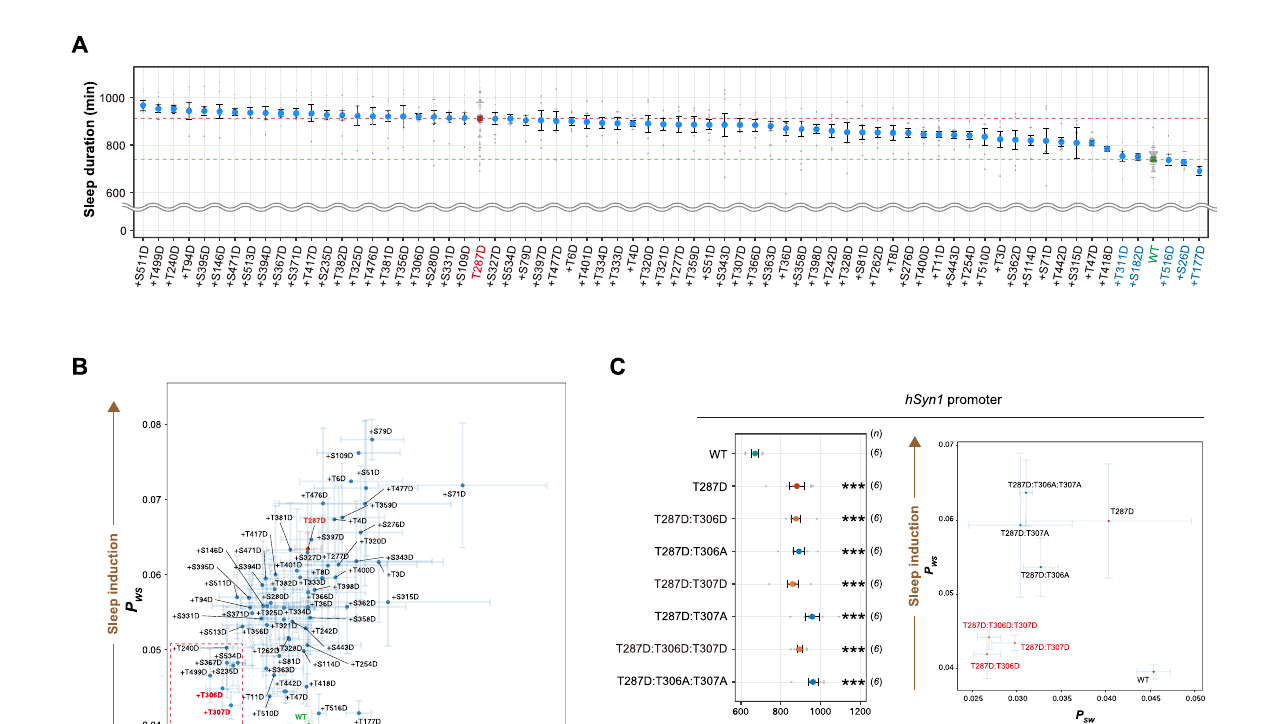
Fig 5. Multisite phosphorylation of CaMKII β regulates sleep maintenance. (A) Daily sleep duration, averaged over 6 days, of mice expressing CaMKII β double-phosphomimetic mutants ( n = 5–12). The dashed green and red lines represent the averaged sleep duration of mice expressing WT CaMKII β (WT, n = 71) and T287D mutants (T287D, n = 68), respectively. The plus sign in a mutant’s name indicates a combination with T287D. Mutants marked in blue were selected for further analysis as sleep-canceling residues, related to Fig 6A. (B) Correlation diagram of daily P WS and P SW of mice expressing the CaMKII β double-phopshomimetic mutants shown in Fig 5A, averaged over 6 days. The mutants (including